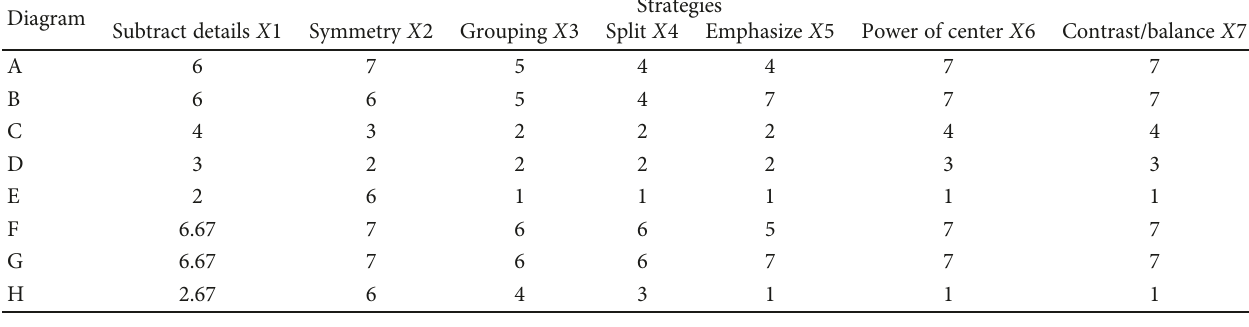
Table 2: Strength levels of the artistic strategies in the eight ATM architectures.